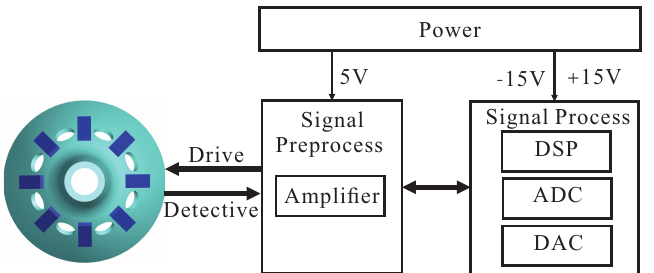
Figure 5. The structure of the circuit